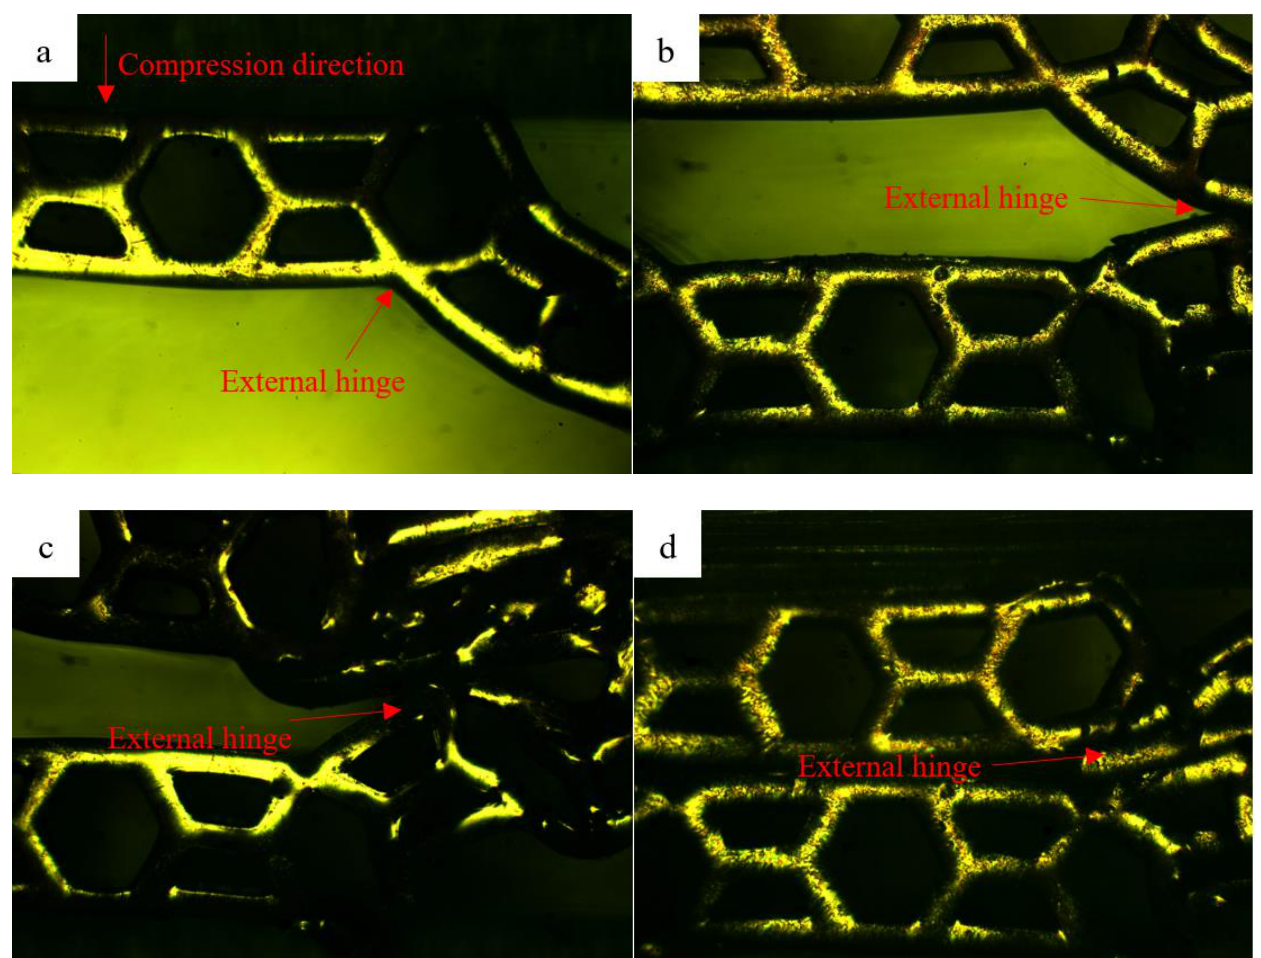
    = 0.12, ( b ) = 0.29, ( c ) = 0.38, ( d ) = 0.56.